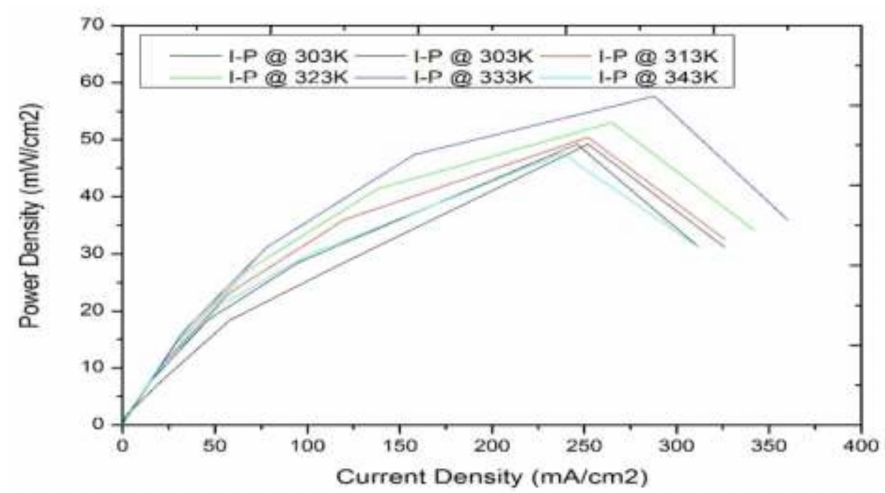
Figure 10. C CH3OM : Steady-state current density–power density curve.